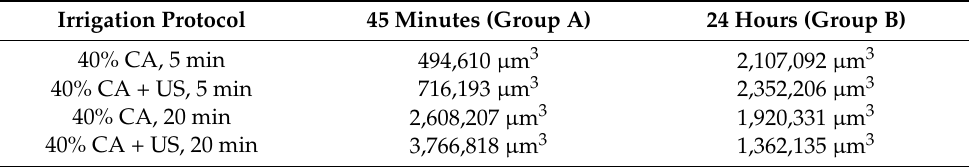
Table 3. The mean values of volume loss ( µ m 3 ) in Biodentine samples after CA irrigation with or without US activation.